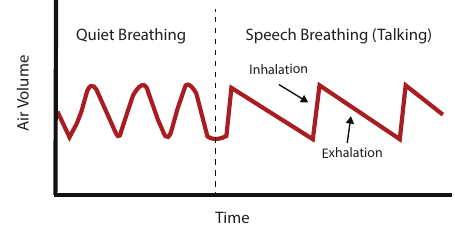
Figure 3. Changes in the air volume while